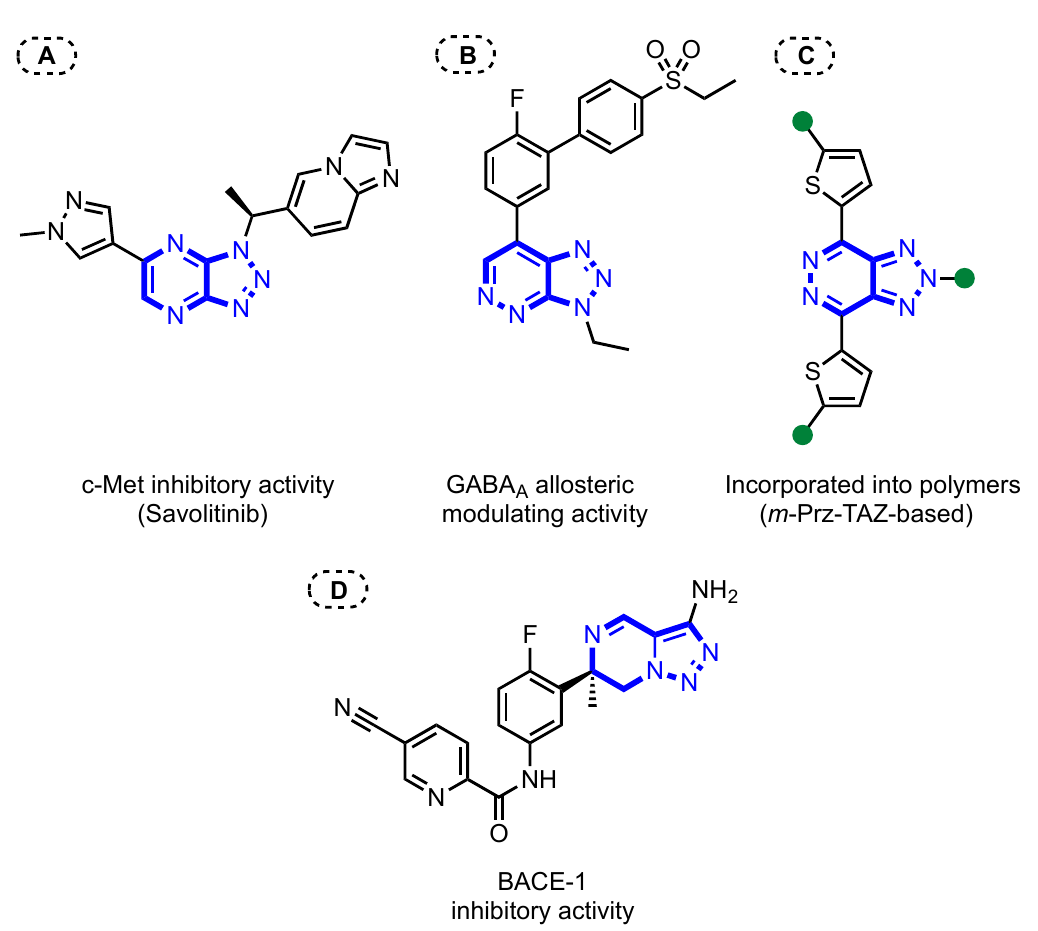
Figure 2. Examples of useful structures containing 1,2,3-triazole-fused pyrazines and pyridazines: ( A ) c-Met inhibitor Savolitinib [1], containing a 1,2,3-triazolo[4,5- b ]pyrazine, ( B ) a compound with GAGA A allosteric modulating activity containing a 1,2,3-triazolo[4,5- c ]pyridazine [3], ( C ) a 1,2,3- triazolo[4,5- d ]pyridazine derivative used in polymers for solar cells [4,5], and ( D ), a 1,2,3-triazolo[1,5- a ]pyrazine derivative with BACE-1 inhibitory activity [6].